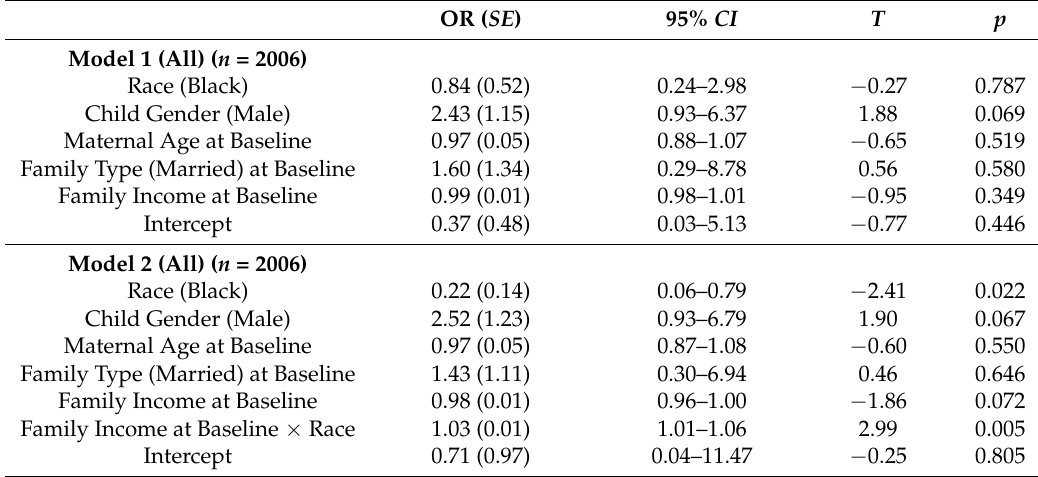
Table 2. The results of logistic regressions in the overall sample.